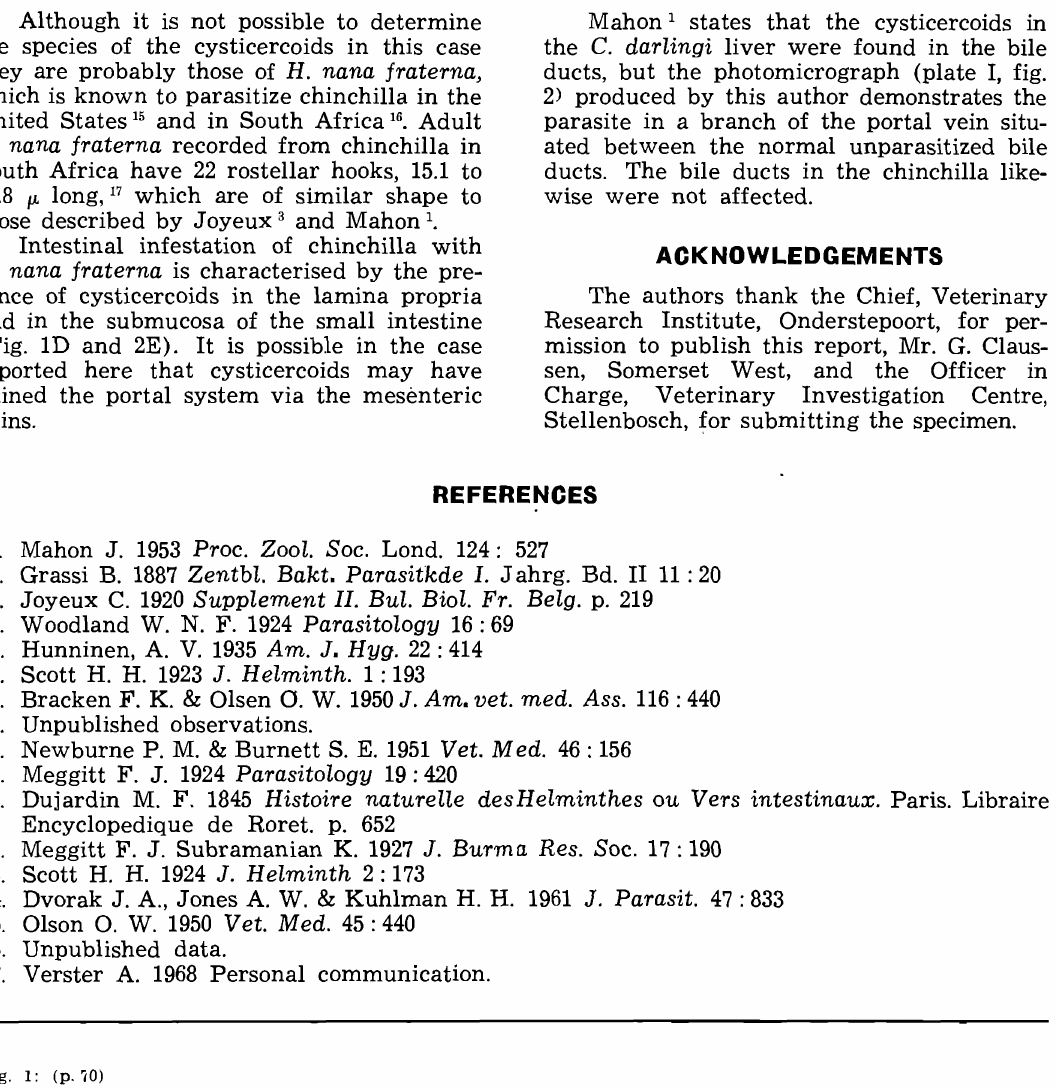
Fig. 1: (p. 70) , A. Section through the scolex of a cysticercoid in the liver . demonstrating the hooks. Hand E. X 200. B. Section through a cysticercoid in a portal vein of the liver. Severe fatty degeneration of hepatocytes. Hand E. x 75. C. Section through cysticercoid in liver. surrounded by eosinophils. Hand E. X 200. D. Small-intestine with cysticercoid in lamina propria. Hand E. X 200. Fig. 2: (p.72) A. Unstained preparation of scolex with rostellum in centre. surrounded by suckers. Phase-contrast. X 480. B. Three isolated cysticercoids. unstained. X 30. C. Necroses and haemorrhage in adjacent liver lobules Hand E. x 75. D. Variation in shape of hooks. Photomicrographs. E. Cysticercoid in submucosa of small-intestine. Hand E. X 200. F. Eosinophils and round cells surrounding parasits (arrow). in liver. Hand E. X